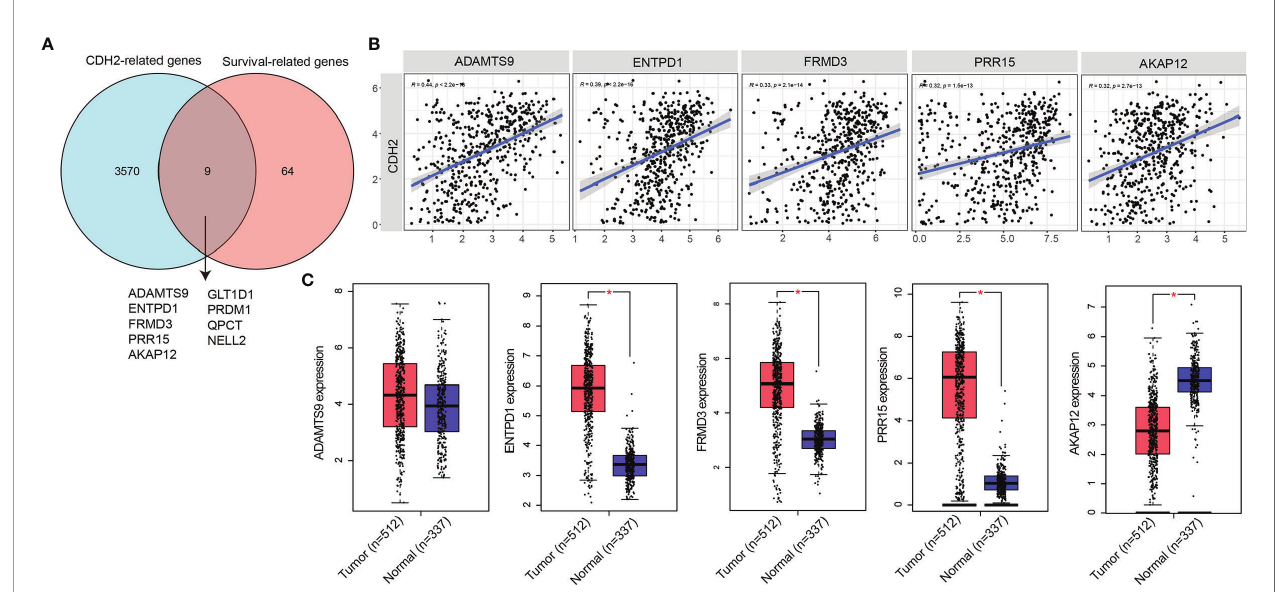
FIGURE 3 | CDH2-related genes in THCA. (A) Venn diagram showed the intersecting part in CDH2-related genes and OS-related genes. (B) The correlation between CDH2 and ADAMTS9, ENTPD1, FRMD3, PRR15, AKAP12 showed a strong positive correlation. (C) The mRNA expression levels of ADAMTS9, ENTPD1, FRMD3, PRR15, AKAP12 of tumor tissues and normal tissues in THCA were generated by GEPIA database. *P <